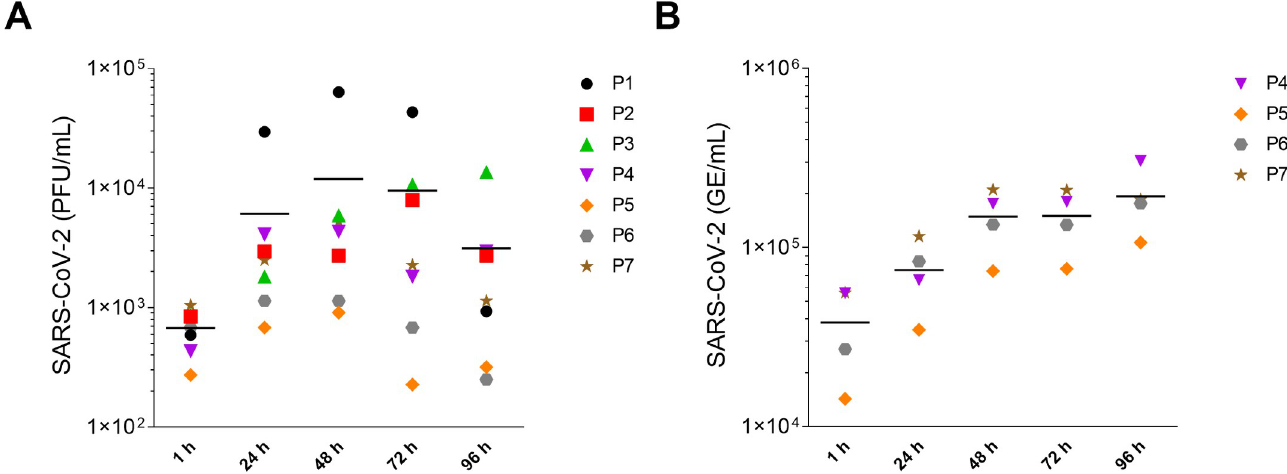
Fig 3. Replication kinetics of SARS-CoV-2-infected human alveolar-like organoids. Human alveolar-like organoids were infected with SARS-CoV-2 (MOI = 1) and viral replication was assessed by plaque assay (A) and via viral E gene-based RT-qPCR (B). Data of seven (plaque assay) and four (RT-qPCR) biological replicates are shown as individual data points. The mean is visualized by a horizontal black